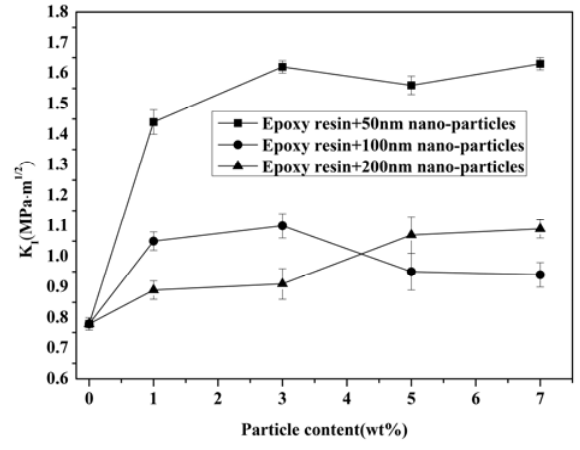
Figure 9. Mode ‐ I fracture toughness of epoxy resin modified by nano ‐ Al 2 O 3 . Figure 9. Mode-I fracture toughness of epoxy resin modified by nano-Al 2 O 3